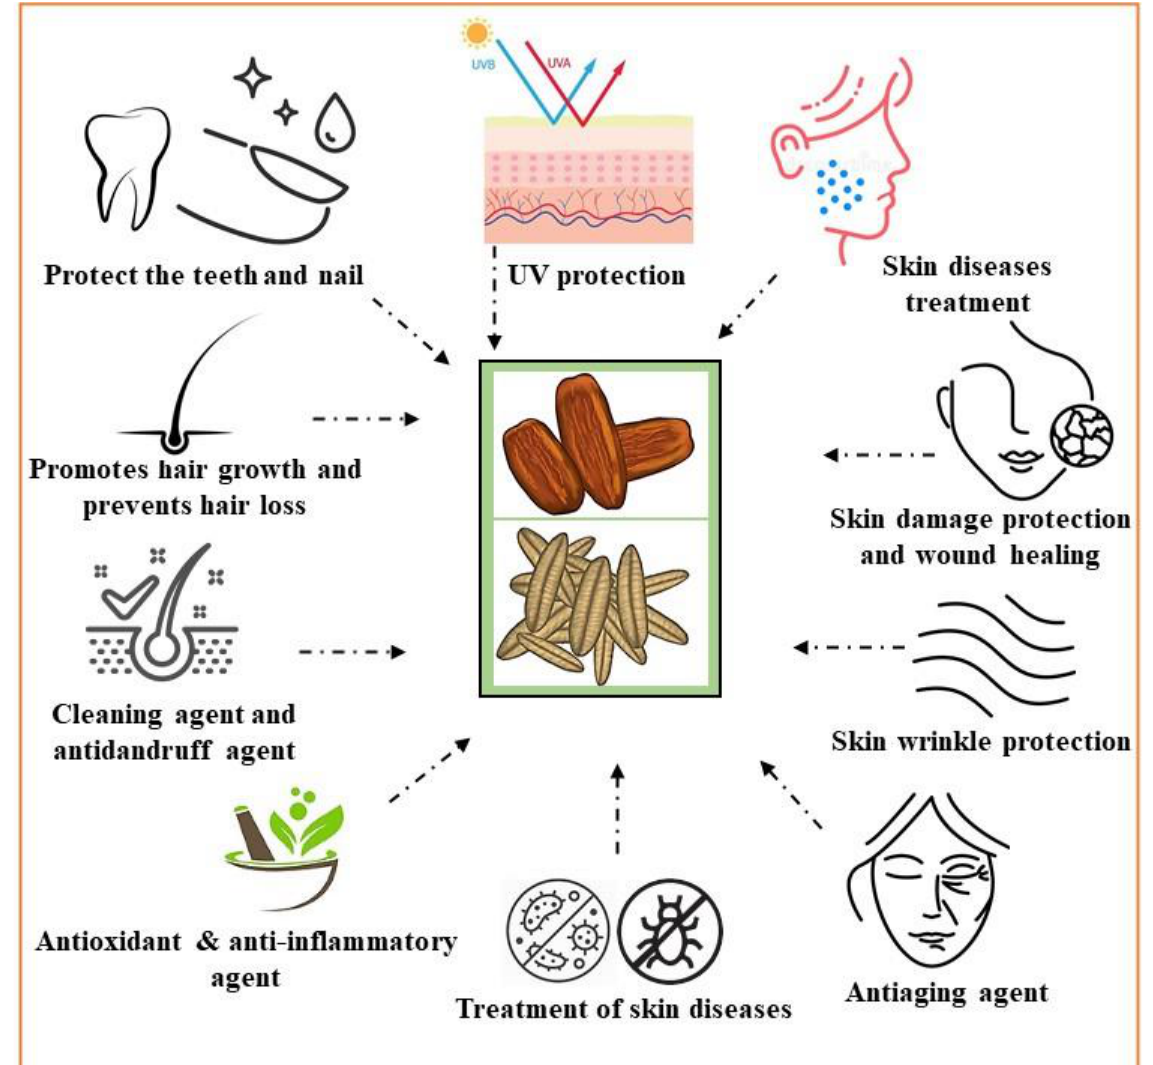
Figure 3. Illustration of the cosmetic applications of date fruits and